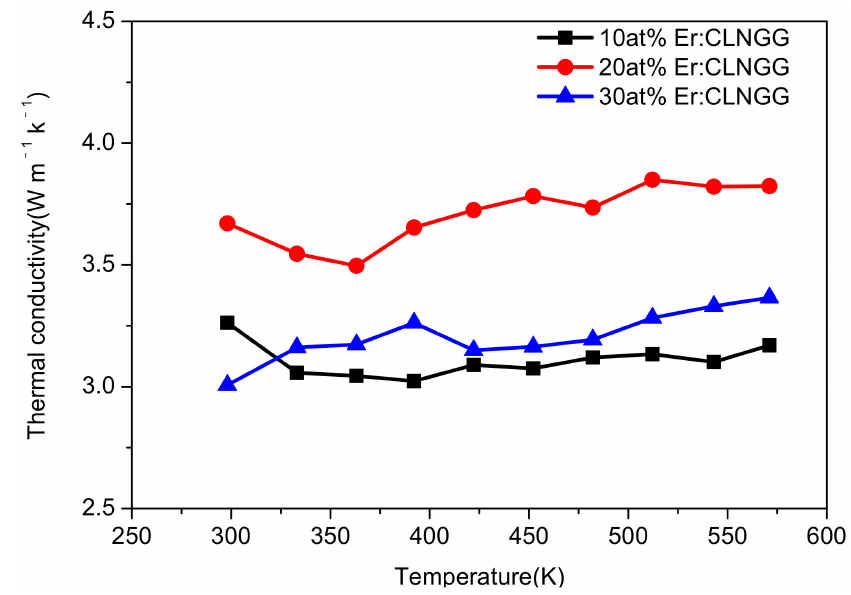
Figure 7. Thermal conductivity of Er:CLNGG crystal as a function of